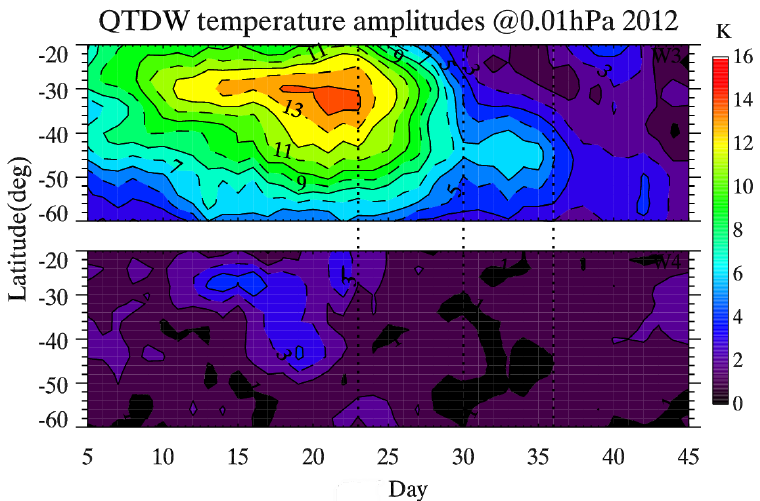
Figure 4. The same as Figure 2 but for year 2012.